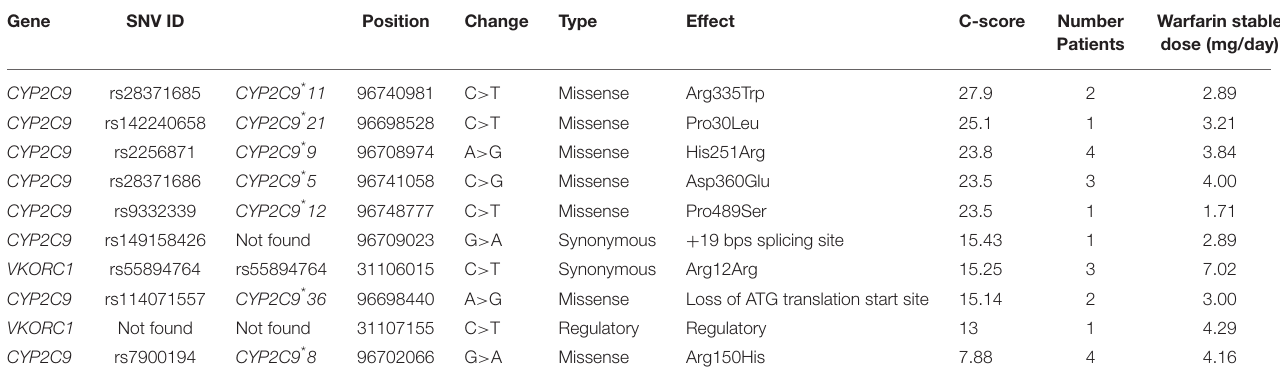
TABLE 6 | Evaluation of low-frequency variants identified with NGS. Gene SNV ID Type Effect C-score Number